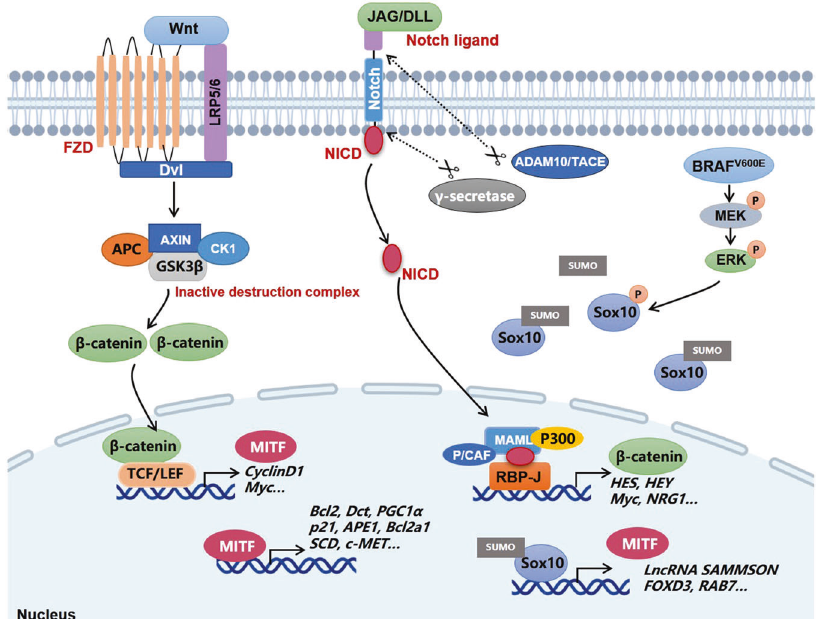
Fig. 4 Key transcriptional factors and signal pathways in melanoma. ADAM10 ADAM metallopeptidase domain 10, APC adenomatosis polyposis coli, DLL delta-like canonical Notch ligand, DVL Disheveled segment polarity protein, FZD frizzled class receptor, GSK3 β Glycogen synthase kinase 3 β , JAG jagged canonical Notch ligand, LEF-1 lymphoid enhancer binding factor 1, LRP5/6 low density lipoprotein receptor- related protein 5/6, MAML mastermind-like transcriptional coactivator, NICD Notch intracellular domain, P/CAF P300/CBP-associated factor, RBPJ recombination signal binding protein for immunoglobulin κ J region, TACE TNF α -converting